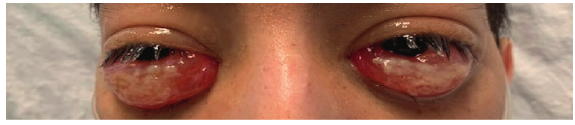
Figure 1: Severe inferior chemosis seen on admission.